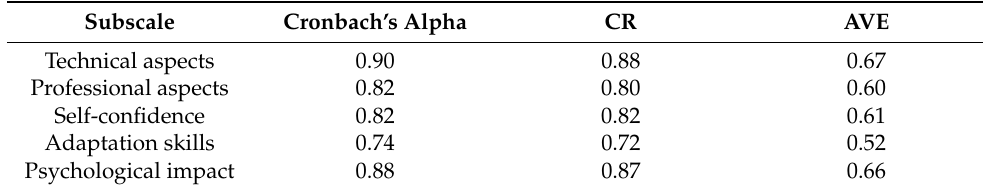
Table 5. Cronbach’s alpha parameters of the subscales.